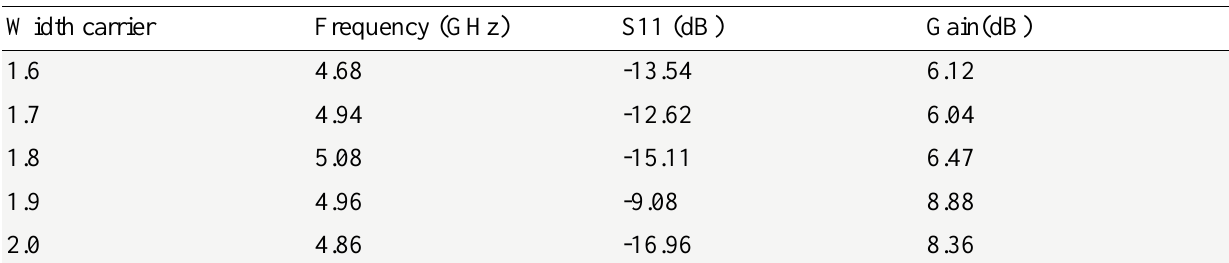
Table 8. Port/via carrier width